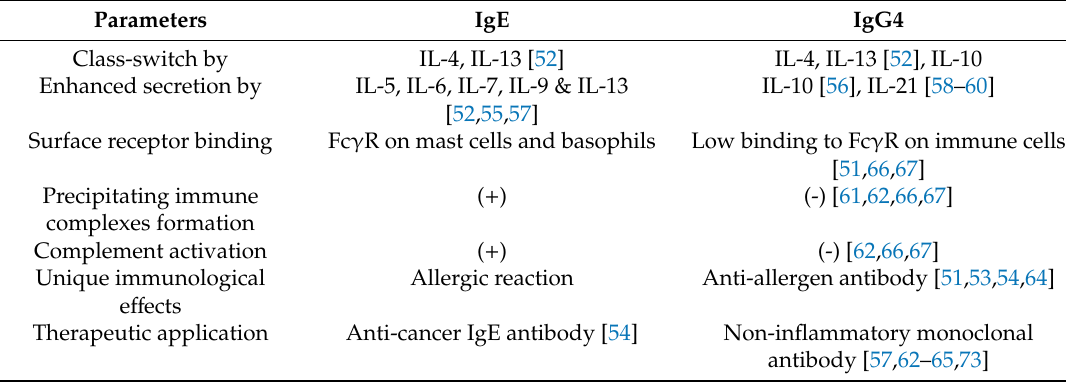
Table 4. Di ff erences in the regulation, modes of action and clinical applications between IgE and IgG4